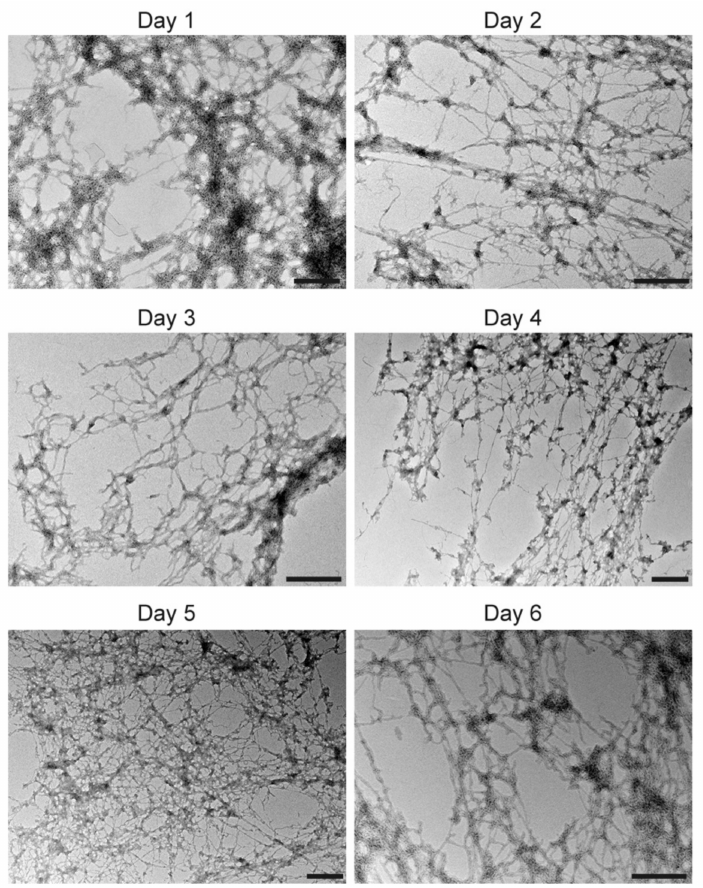
Figure 5. Stability of membrane tubes formed by the peptide 2C-wt; 2C-wt peptides (50 µ M) were incubated with 1000 nm POPG vesicles (500 µ M). The tubes were imaged for six days using transmission electron microscopy. No change in tube morphology was observed until day six. Scale bar = 500